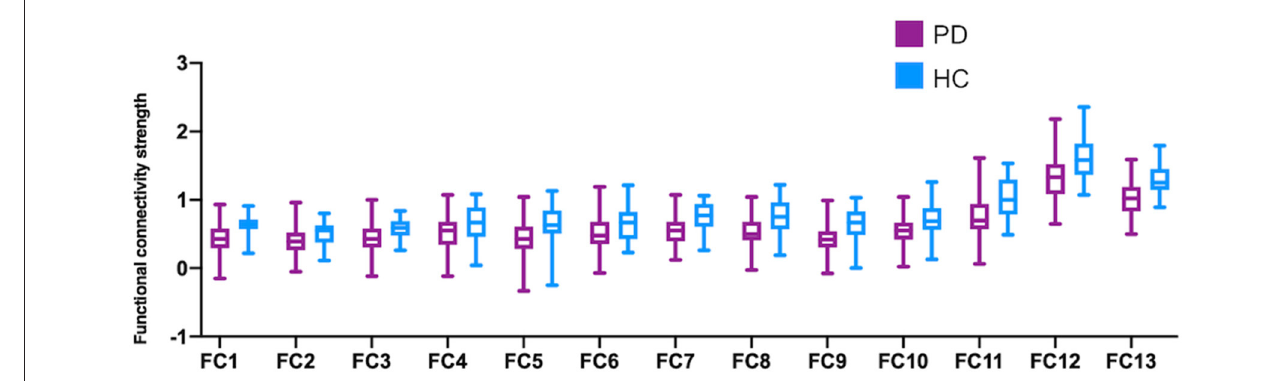
FIGURE 2 | Functional connectivity strength comparisons between PD and HC.